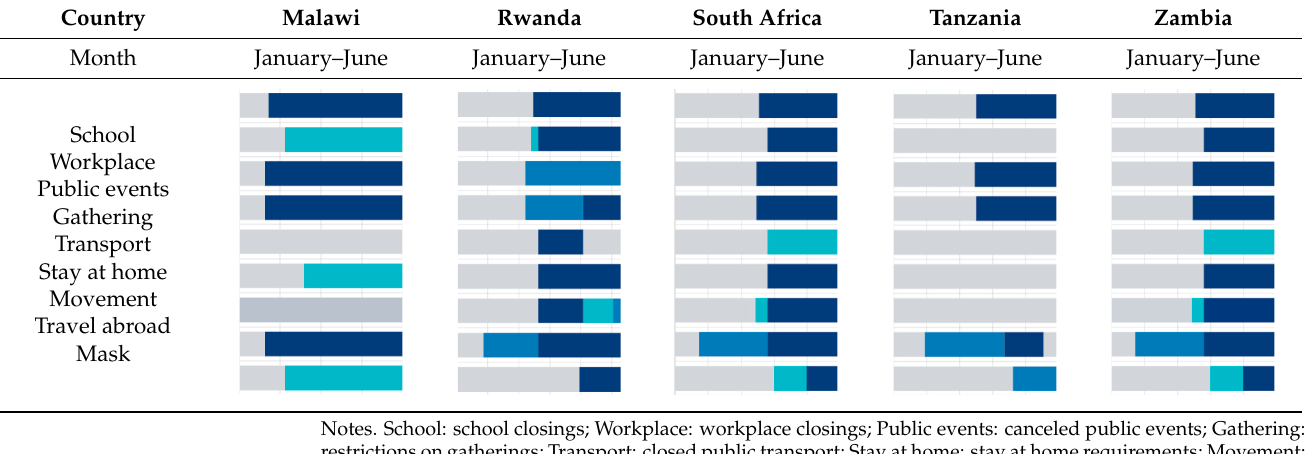
Table 3. Comparison PHSM index between pre-and post-COVID-19 outbreak (Resource: Africa CDC).